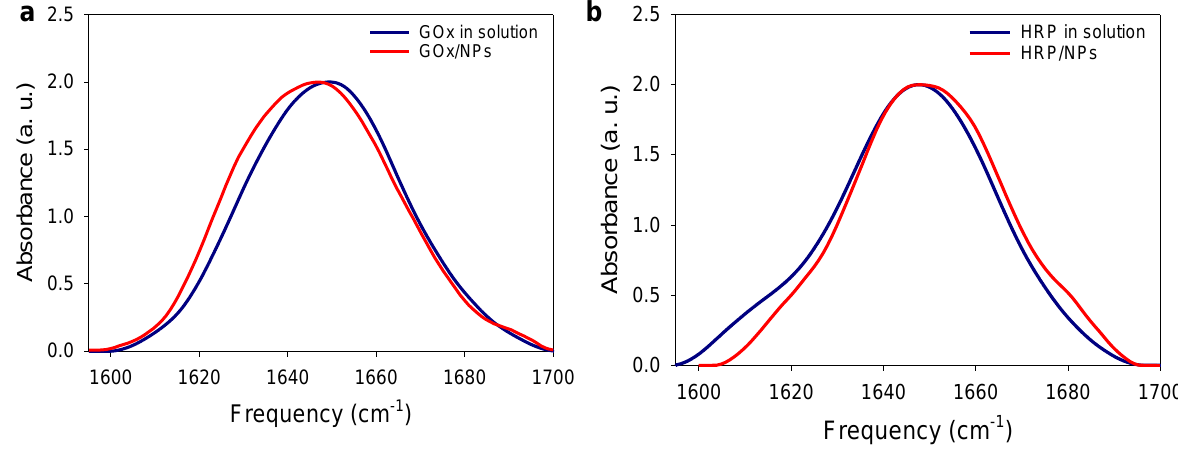
Figure 8. FTIR normalized spectra, amide I band region ( a ) of GOx solution (10 mg/mL) and GOx/NPs suspension and ( b ) of HRP solution (10 mg/mL) and HRP/NPs suspension, prepared in D 2 O.